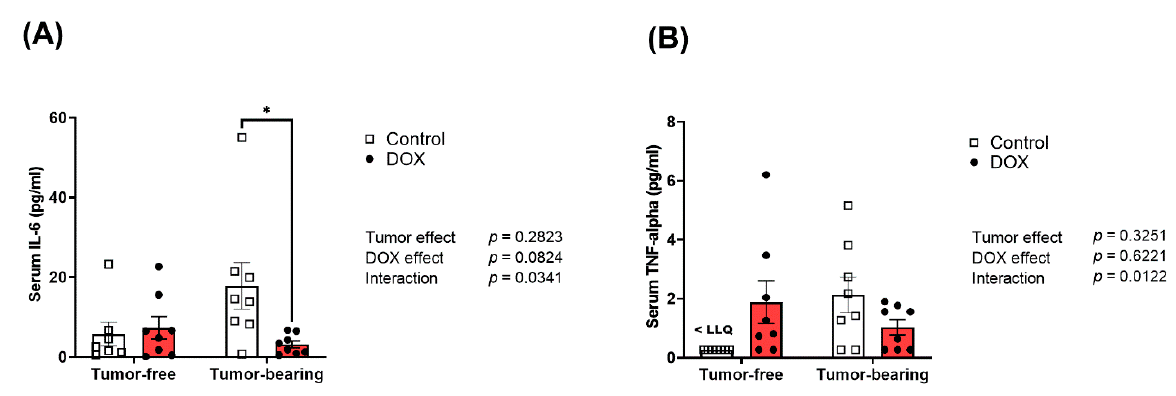
Figure 7. Divergent effects of DOX treatment on the serum level of inflammatory markers in tumor-free versus tumor-bearing mice. Serum was collected from tumor-free and EL4 lymphoma tumor-bearing juvenile C57BL/6N mice one week following the administration of 4 mg/kg/week of DOX or equivalent volume of sterile saline for 3 weeks ( n = 7–8 per group). Inflammatory markers ( A ) IL-6 and ( B ) TNF-alpha were measured using the Luminex platform. Data are presented as the mean ± SEM. Two-way ANOVA table demonstrates DOX, tumor, and interaction effects. Statistical significance of pairwise comparisons was determined using two-way ANOVA with Tukey’s post hoc analysis (* p < 0.05).